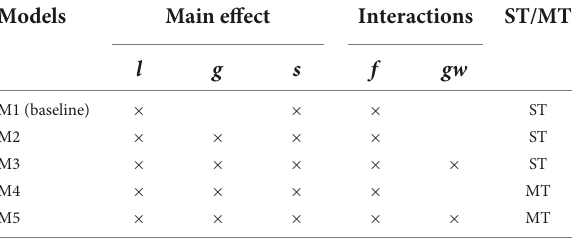
TABLE 2 Summary of the effect included in the models and single-trait (ST) or multi-trait (MT) case.